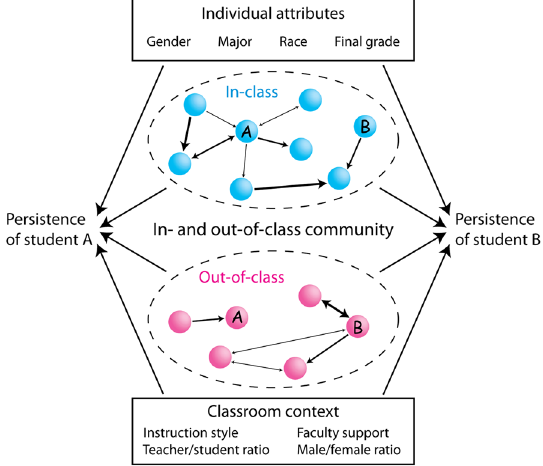
FIG. 1. Model of persistence. We expand the model of persistence proposed in Ref. [7] to include frequency of the interactions and out-of-class networks. The categories of factors that may affect students ’ persistence are individual attributes, classroom context, as well as in- and out-of-class